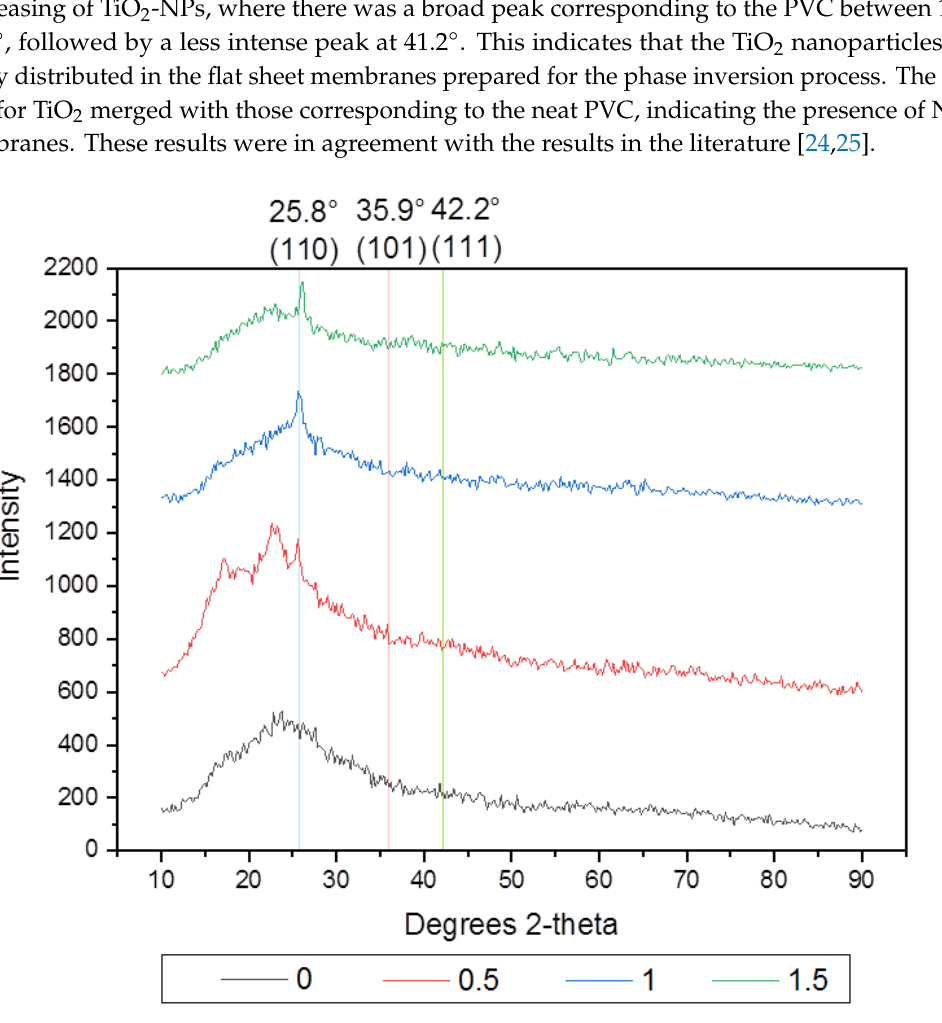
Figure 5. X-ray di ff raction (XRD) spectra of the PVC and PVC / TiO 2 NPs Figure 5. X-ray diffraction (XRD) spectra of the PVC and PVC/TiO 2 NPs membranes.